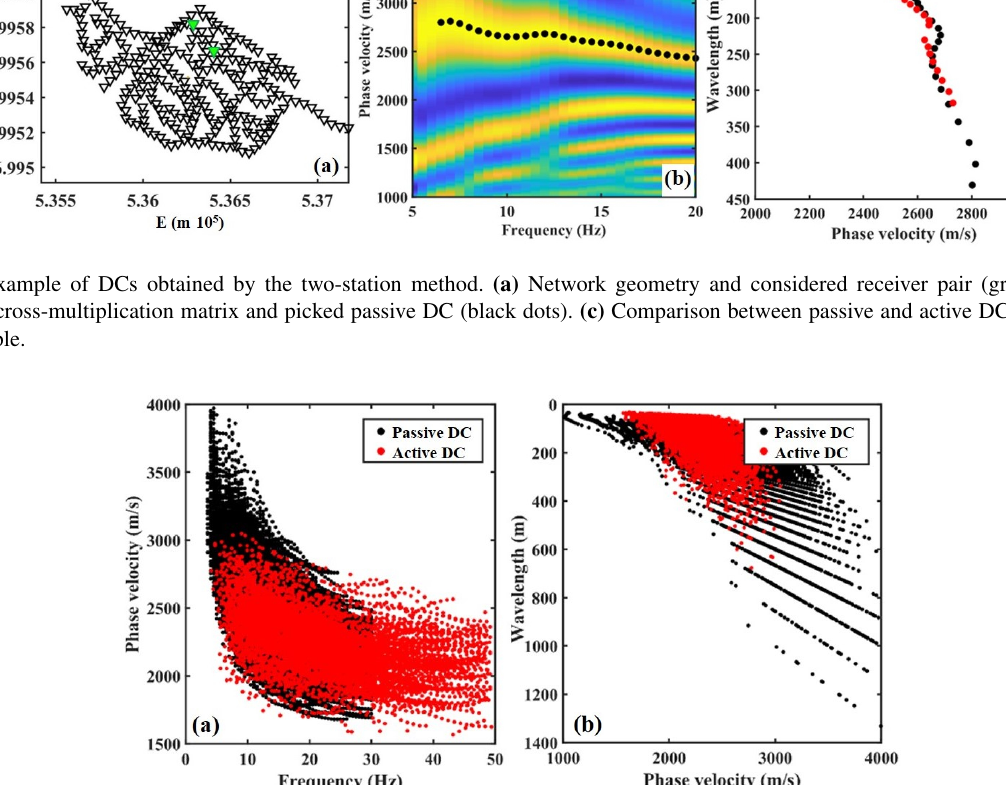
Figure 6. Passive (black) and active (red) dispersion curves. (a) Frequency–phase velocity domain. (b) Wavelength-phase velocity domain.